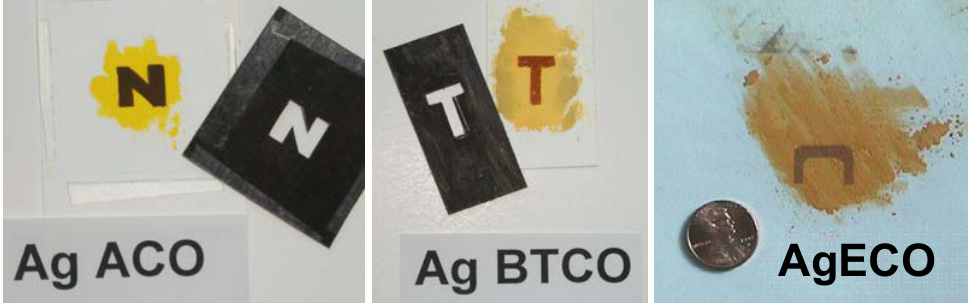
Figure 19. Images on the surface of solid powders of AgL developed after prolonged exposure to the short wavelength UV-radiation (254 nm); shown black cardboard masks and a coin for size comparison.